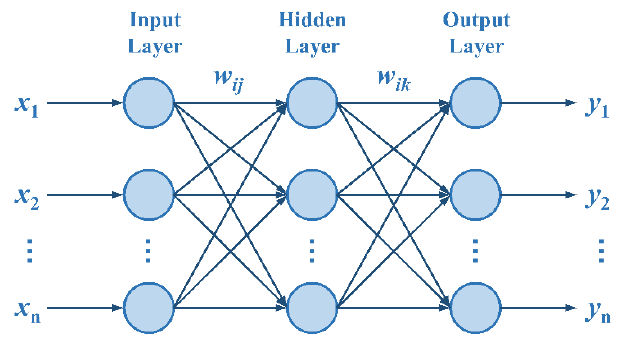
Figure 5. BP neural network model.